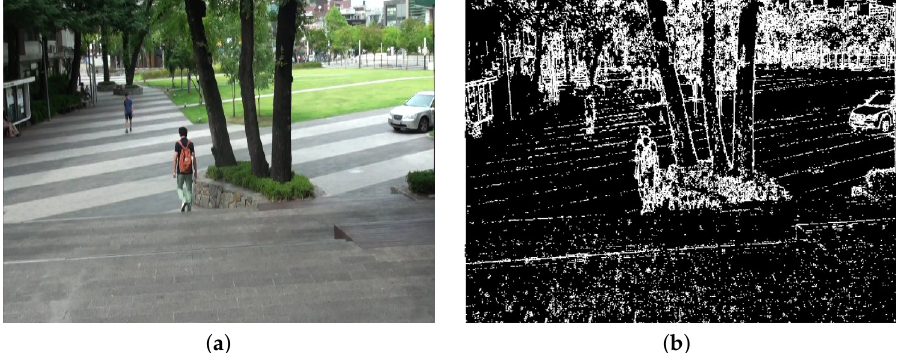
Figure 3. Example of a flat region map: ( a ) an input image and ( b ) its flat region map using the proposed